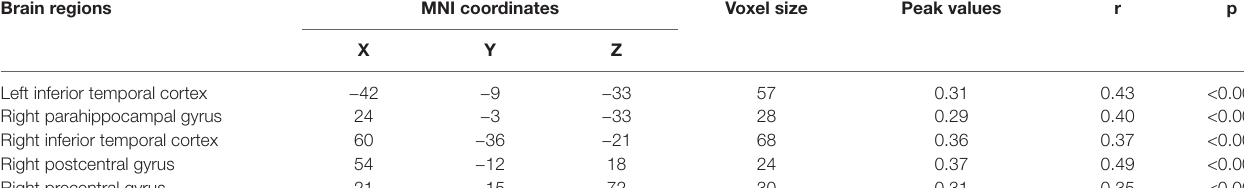
TABLE 1 | Brain regions with significant correlations between ALFF signals and state anxiety. Brain regions